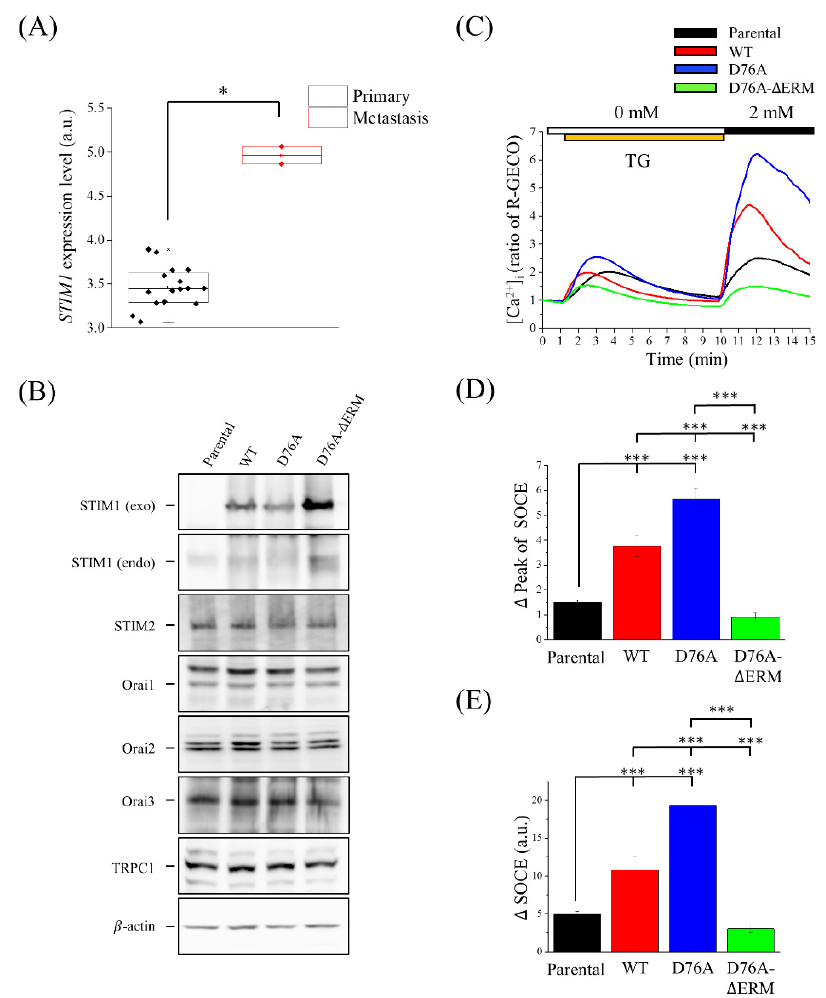
Figure 1. STIM1 variants regulate SOCE level in the U2OS osteosarcoma cell line. ( A ) The box plot represents STIM1 gene expression levels in the primary or metastatic osteosarcoma cell lines. Data was analyzed from GEO dataset. ( B ) Cells were transfected with or without STIM1 variants. Antibodies against SOCE-related proteins, including exogenous and endogenous STIM1, STIM2, Orai1, Orai2, Orai3, and TRPC1, were used in the immunoblotting analysis. β -actin served as the internal control. ( C ) Representative result of changes in intracellular Ca 2+ levels in the cells transiently transfected with R-GECO, of which fluorescence ratio intensity represented the Ca 2+ level. Extracellular 2mM Ca 2+ buffer was added at the tenth minute. Each trace was obtained by averaging data from 15–44 cells. TG, thapsigargin. ( D ) Quantification of the maximum peak of SOCE. Bars represent the mean ± standrad error of the mean (SEM). ( E ) Quantification of the area under SOCE curve which indicates SOCE-mediated total Ca 2+ influx. Bars represent the mean ± SEM. * p < 0.05, *** p < 0.001 by Mann-Whitney test in ( A ), one-way analysis of variance (ANOVA) in ( D ) and ( E ). a.u., arbitrary unit.